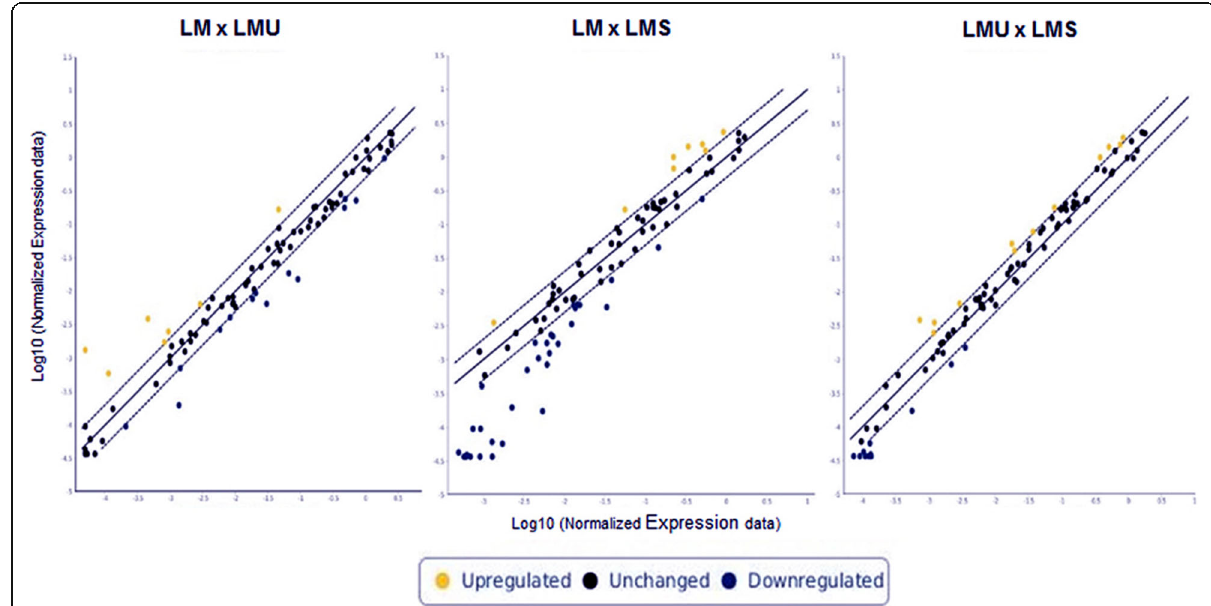
Fig. 2 Diferential miRNA expression between tumor types. Scatter plots present a global analysis of the miRNAs that were found to be differentially expressed among the tumors examined